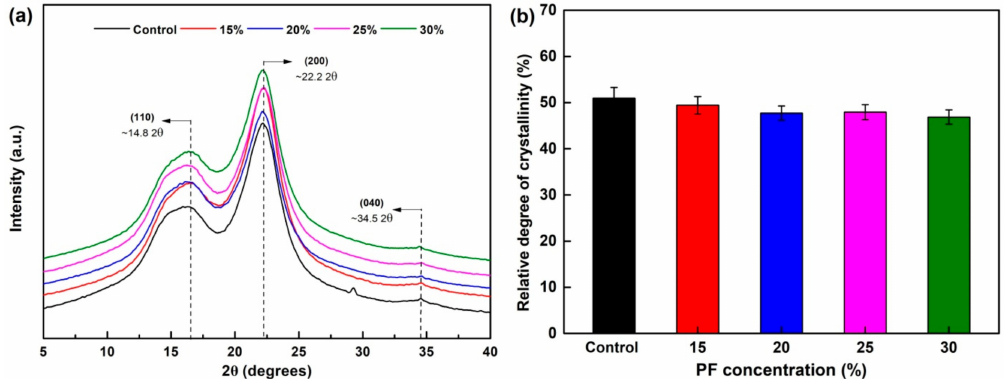
Figure 6. XRD analysis of the control and PF-modified wood: ( a ) XRD spectra and ( b ) the degree of